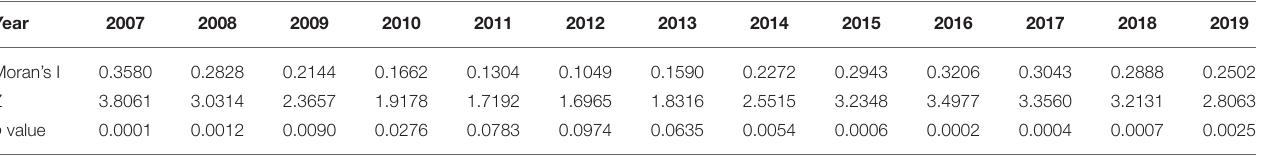
TABLE 1 | The Moran’s I statistics of the supply level of healthcare